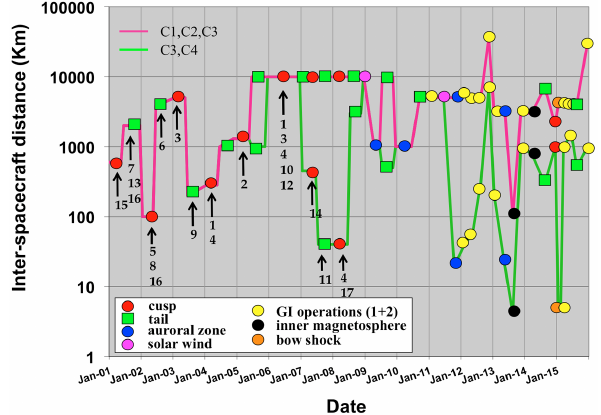
Figure 2. Cluster constellation from the beginning of mission up to now. The distance between the spacecraft is given as a function of time: C1, C2 and C3 separation distance in magenta and C3 and C4 in green. The distance is given at one point along the orbit defined by the symbol and colour in the legend. The arrows and numbers refer to Cluster constellations used in the new scientific highlights presented in this